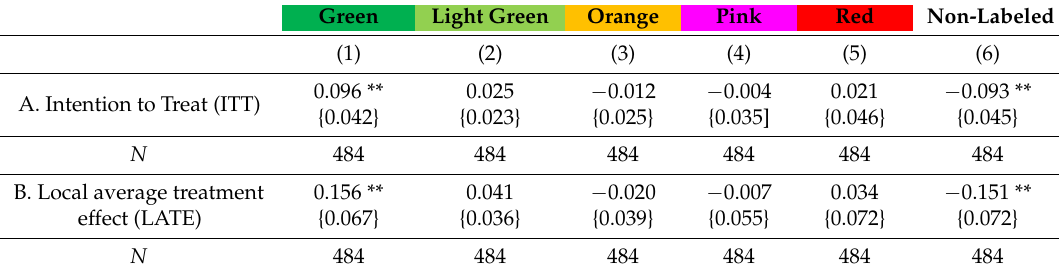
Figure 5. Fraction of items bought by color composition and randomization group. Table 5. ITT and LATE effects of providing Nutri-Score Label information on the probability of purchasing at least one item of a particular color using a linear probability model (LPM).